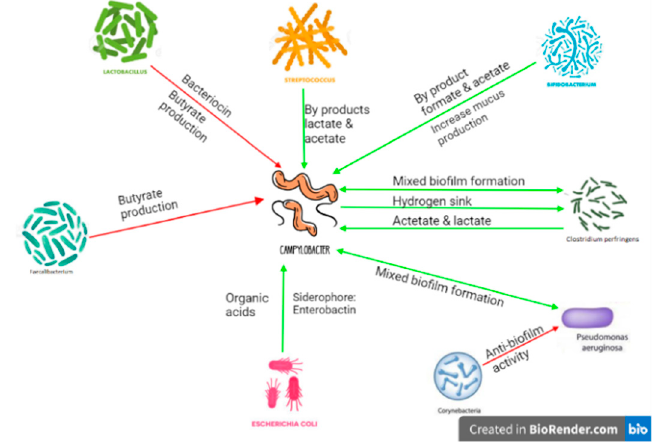
Figure 2. C. jejuni interactions with the gut microbiota. Created with BioRender.com (accessed on 29 January 2023).